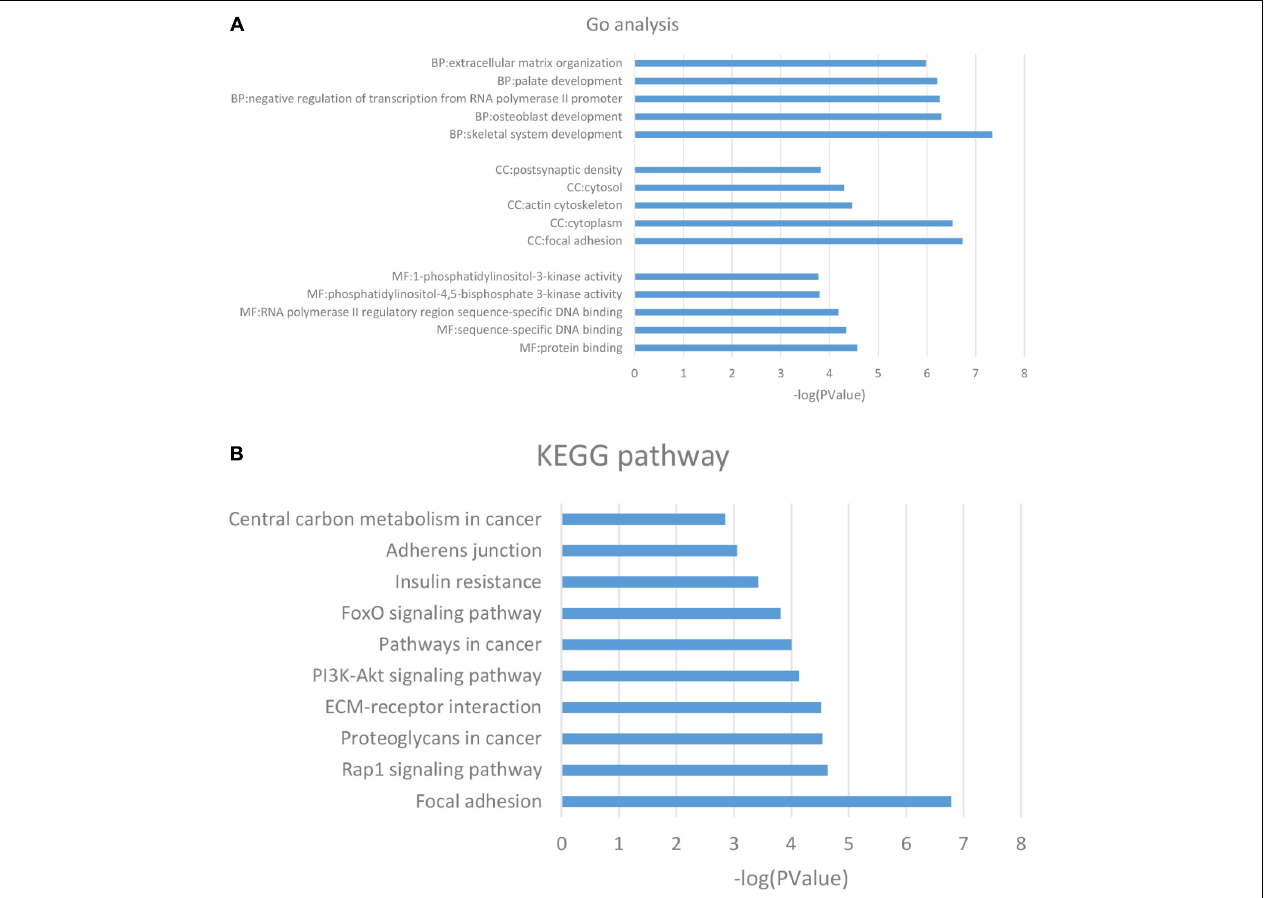
FIGURE 2 | (A) GO analysis of the DMGs. (B) KEGG pathway analysis of the DMGs. The columns are represented as the negative log10 of the P -value. DMGs: differentially methylated genes; KEGG: Kyoto Encyclopedia of Genes and